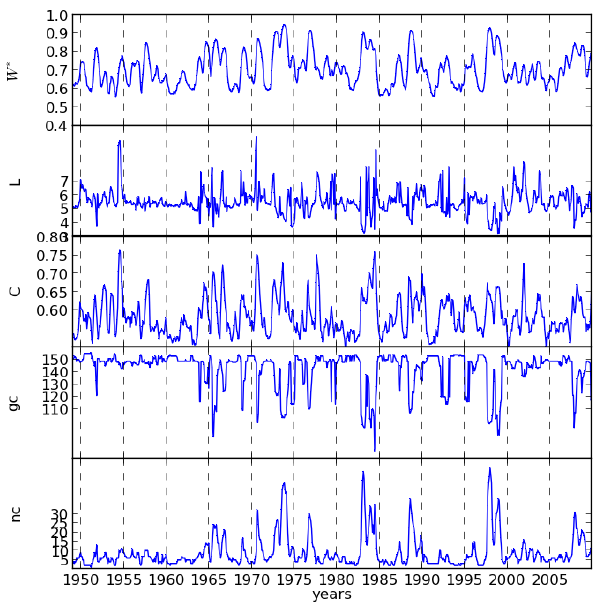
Fig. 10. Evolution of the graph-theoretical properties of the ENSO subgraph: threshold W ∗ , characteristic path length L , average clustering coefficient C , size of the giant component gc and number of connected components nc.